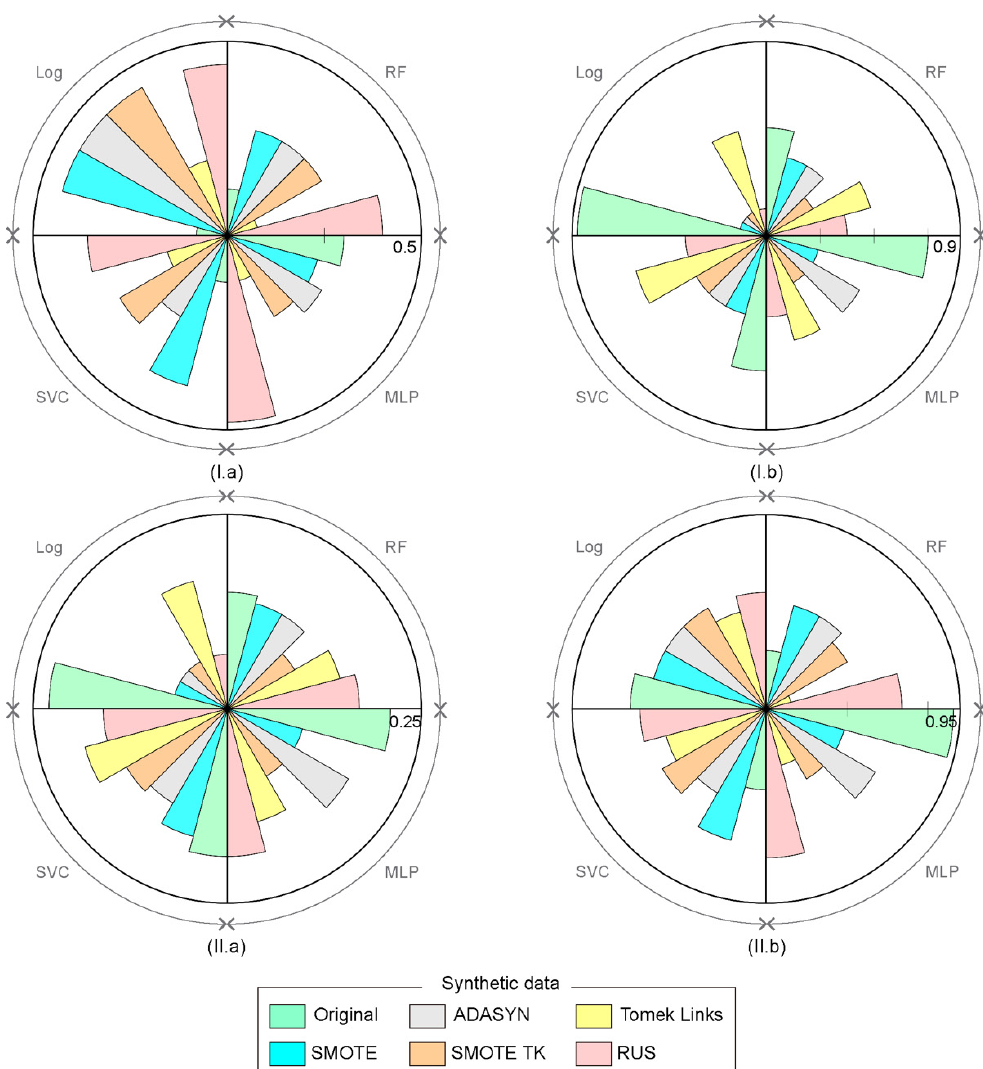
Figure 8. Omission ( I ) and commission ( II ) error for wildfire ( a ) and large wildfire ( b ) classes.